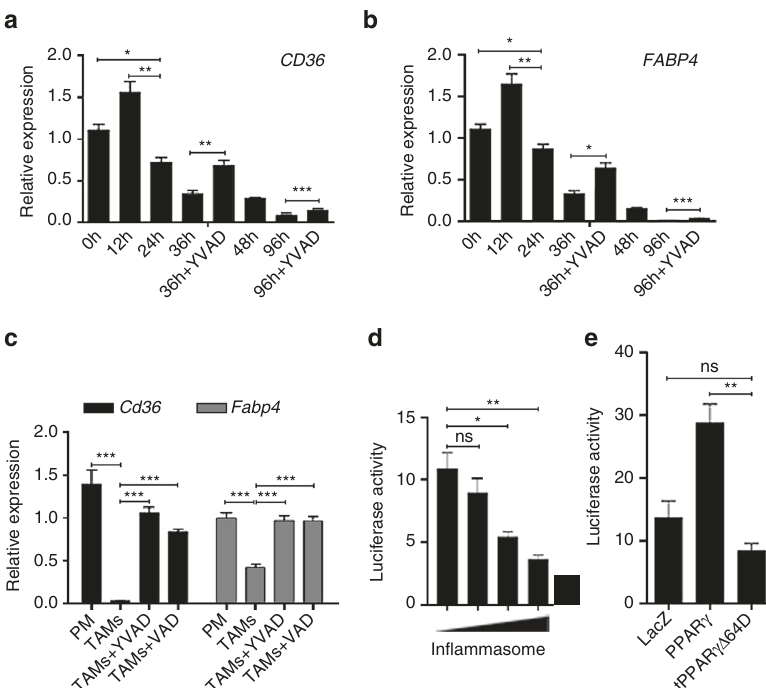
Fig. 3 Caspase-1 cleavage attenuates the transcriptional activity of PPAR γ . a , b THP-1 macrophages were cocultured with MCF-7 for indicated time, in the presence or absence of caspase-1 inhibitor YVAD. CD36 and FABP4 expression was assessed by RT-qPCR( n = 3). c Peritoneal macrophages were isolated from tumor bearing MMTV-PyMT mice, and TAMs were isolated from tumor bearing MMTV-PyMT mice with administration of vehicle, YVAD or VAD, and then the expression of Cd36 and Fabp4 were assessed by RT-qPCR ( n = 8). d HEK293T cells were transfected with PPAR γ -luc reporter plasmids and PPAR γ plasmids, along with increasing concentrations of NLRP3 (100, 200, 300, and 400ng) and caspase-1, ASC plasmids, and then PPAR γ -dependent luciferase activity was analyzed in cell lysates ( n = 3). e HEK293T cells were transfected with PPAR γ -luc reporter plasmids and plasmids expressing LacZ or HA-tagged PPAR γ (PPAR γ ) or N-terminal truncated HA-tagged PPAR γ at Asp64 (tPPAR γΔ 64D), and then the transcriptional activity of different PPAR γ variants were analyzed ( n = 8). All statistic data in this fi gure represent means ± s.e.m., (* P < 0.05, ** P < 0.01, *** P < 0.001, ns, not signi fi cant, one way ANOVA for multiple